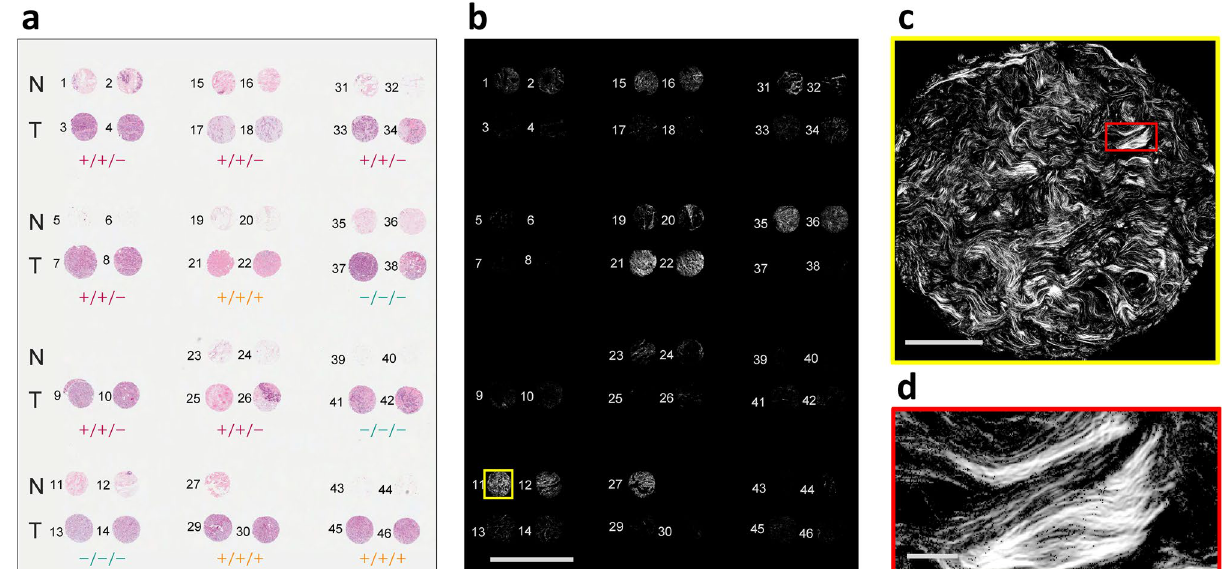
Figure 2. High-throughput widefield P-SHG imaging of tissue microarray. ( a ) A H&E-stained breast tissue microarray containing normal and three distinct tumor subtypes. Enumeration indicates the number assigned to each breast tissue core. The positive sign indicates overexpression of estrogen receptor (ER), progesterone receptor (PR), and human epidermal growth factor receptor 2 (HER2), denoted by ER/PR/HER2. ( b ) Image of circularly-polarized SHG intensity of the entire microarray slide shows distinctive low signal associated with tumor cores, except cores 21 and 22 that possess a large amount of collagenous stroma. Scale bar: 2.5 mm . ( c ) A single widefield SHG image consisting of 2048 × 2048 pixels and an area of approximately 670 µ m × 670 µ m . Scale bar: 200 µ m . ( d ) A magnified region of the tissue, highlighted by red rectangle in c shows high resolution of the imaging technique. Scale bar: 25 µ m